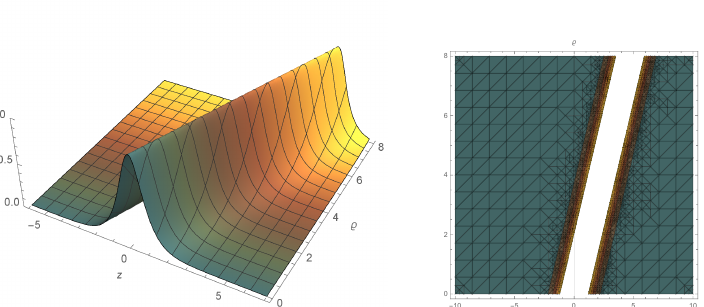
Figure 5. Three-dimensional (3D) and contour plots of the bright soliton solution of Equation (27).